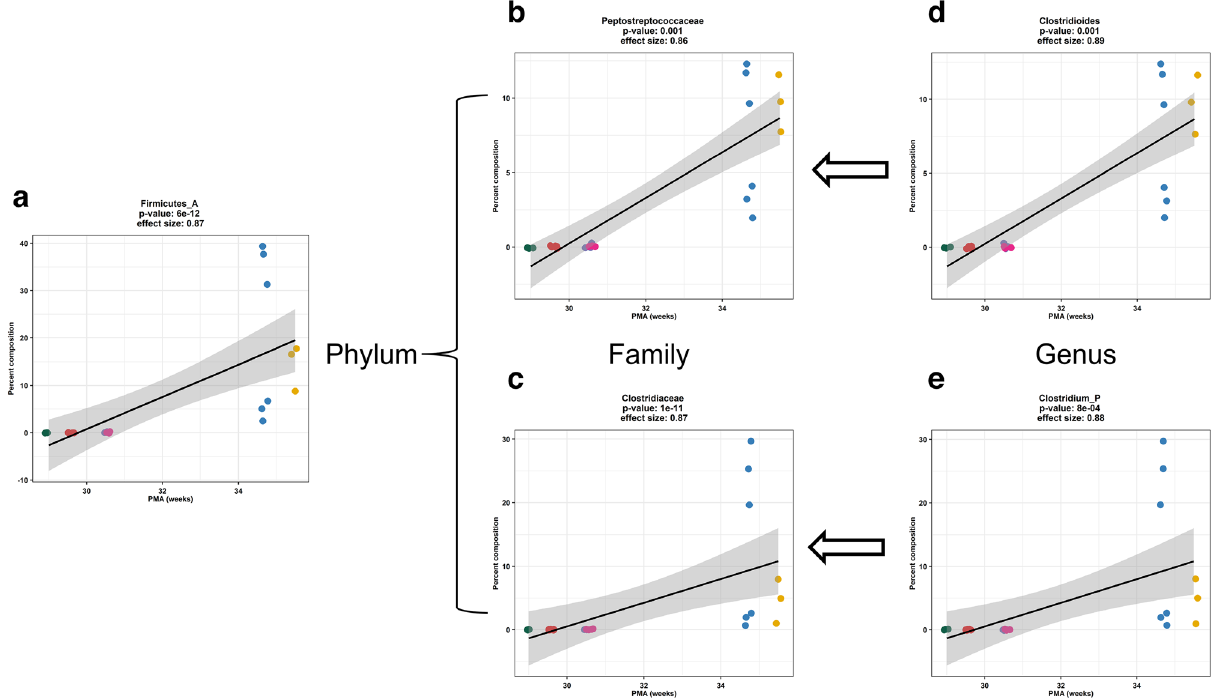
samples. The relative abundance of Firmicutes_A based on operational taxonomic units (OTU) was significantly correlated with PMA ( a , Pearson correlation p < 0.001). At family level, increased PMA positively